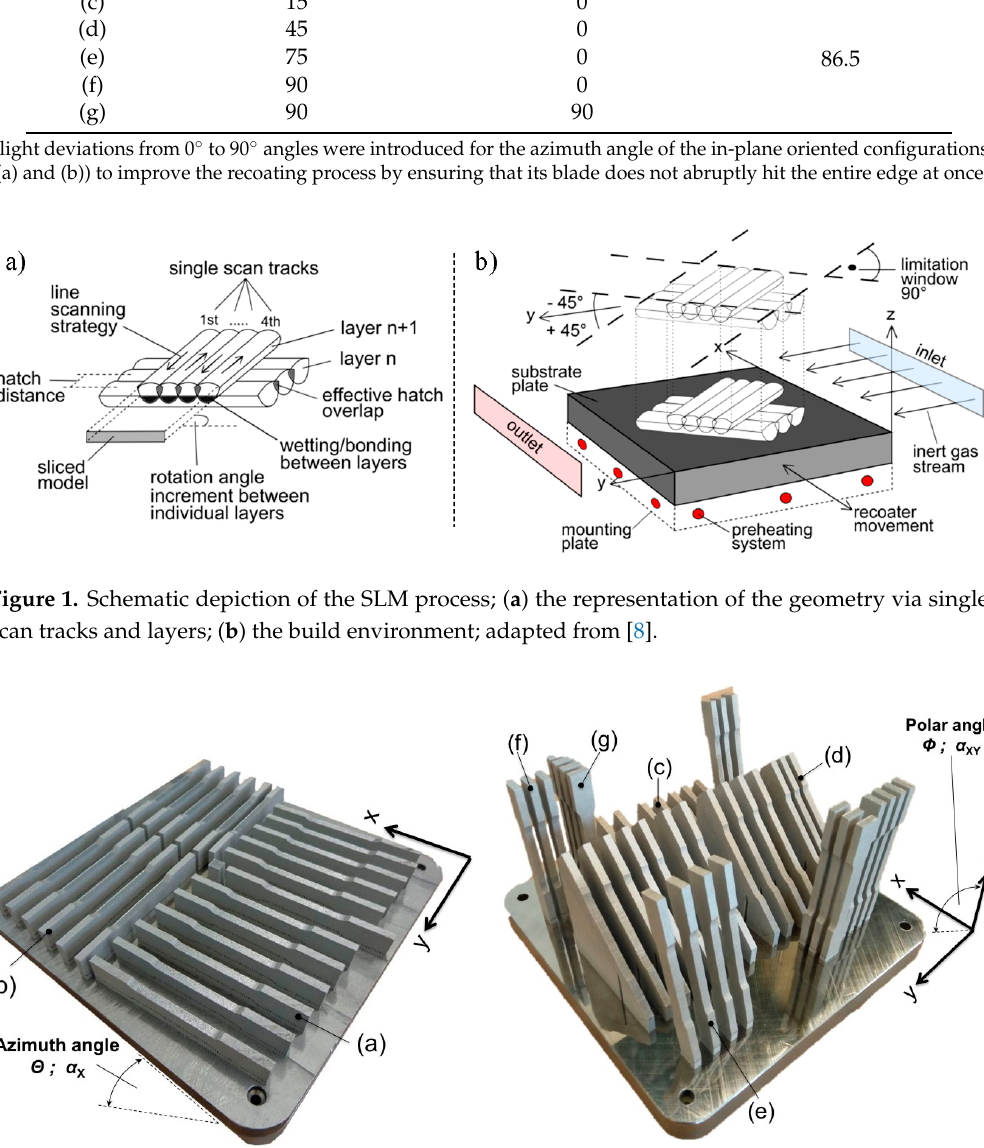
Figure 2. Tensile samples on the substrate plate, overview of the positioning and arrangement.